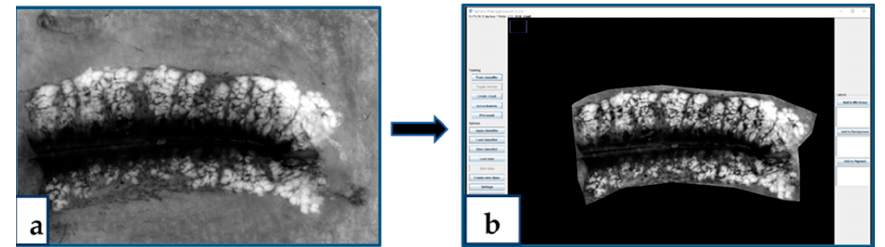
Figure A1. Raw meibograph acquired with the STEMI microscope ( a ) and loaded into image J; then, excess eyelid area was cropped after the CLAHE filter was applied ( b ).